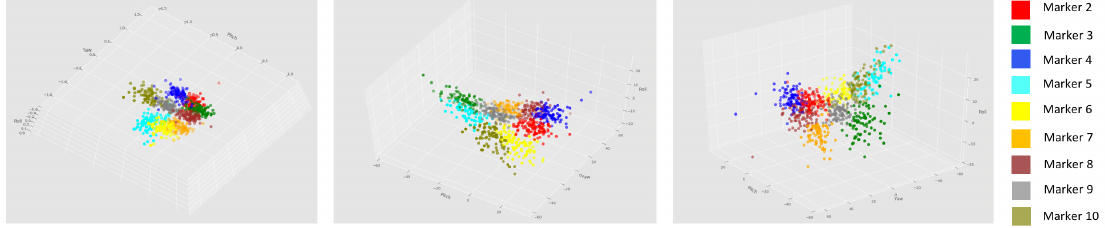
Figure 9. Graphical plots of Euler Angles obtained for the different markers of